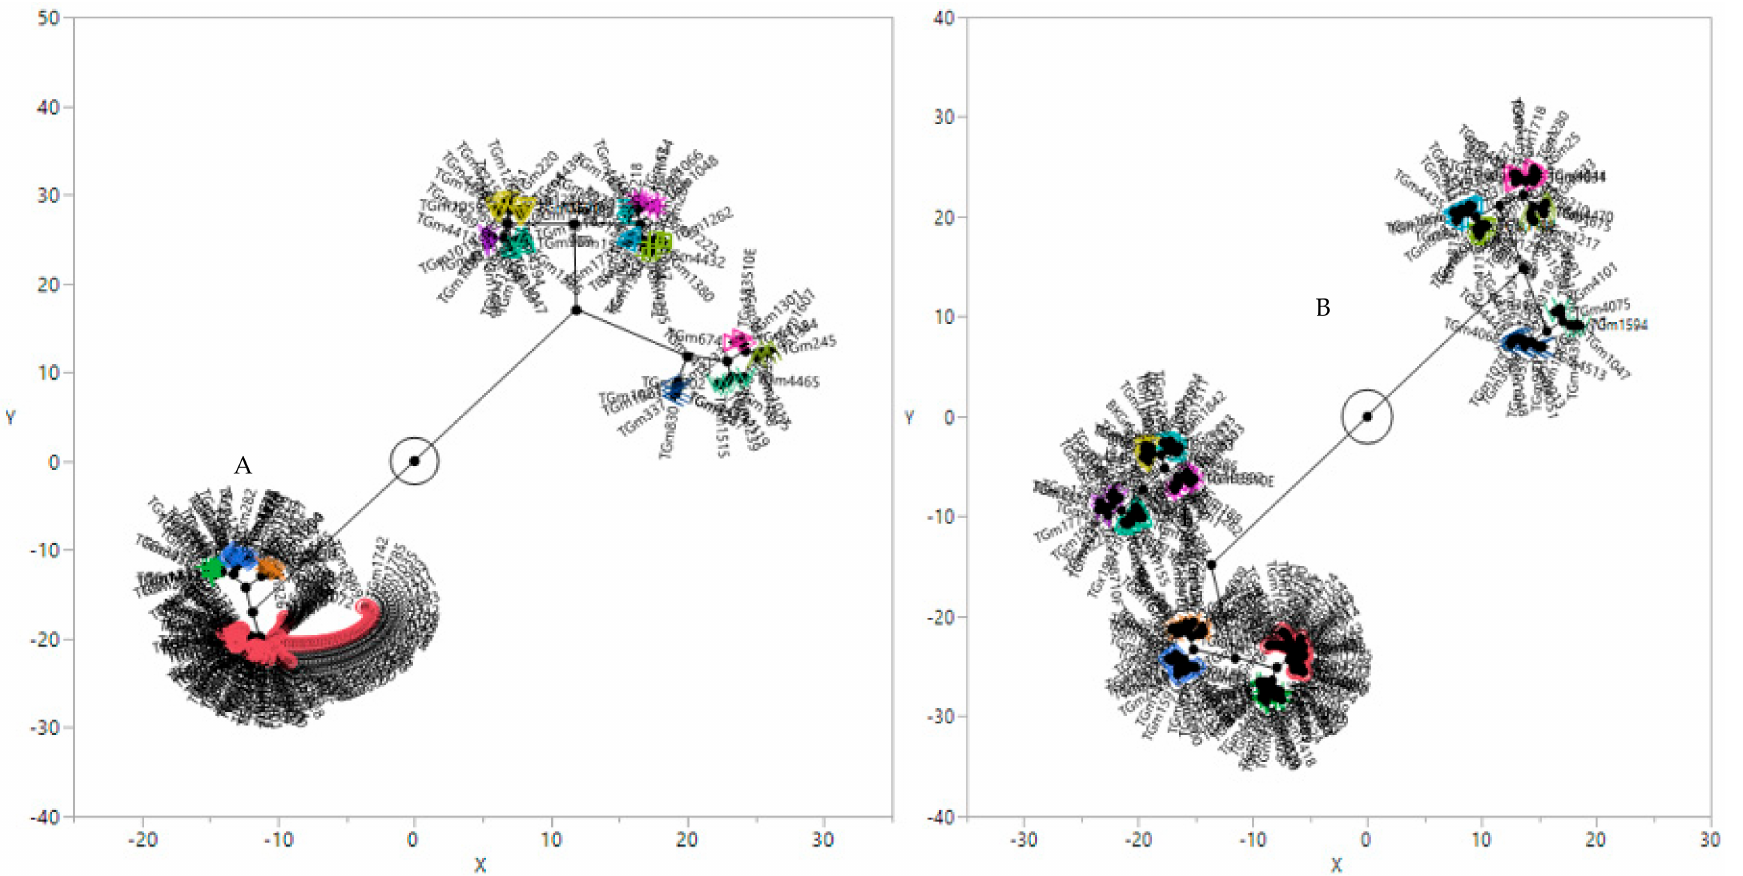
Figure 1. Cluster analysis of the 281 soybean genotypes based on unweighted pair-group method with arithmetic means: ( A ) SNP markers and ( B ) DArT markers. The different colors indicate the different clusters